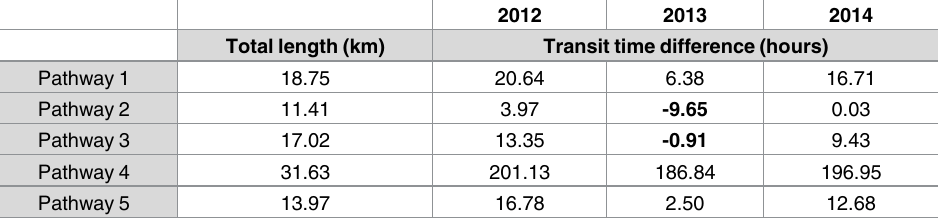
Table 2. Transit time difference (water transit time, minus egg hatching time) for each available egg pathway within the canal network, for every year when YOY were captured. Bold values highlightincom- patible times of transit (negativevalues indicatethat eggs wouldhatch beyond the end of the